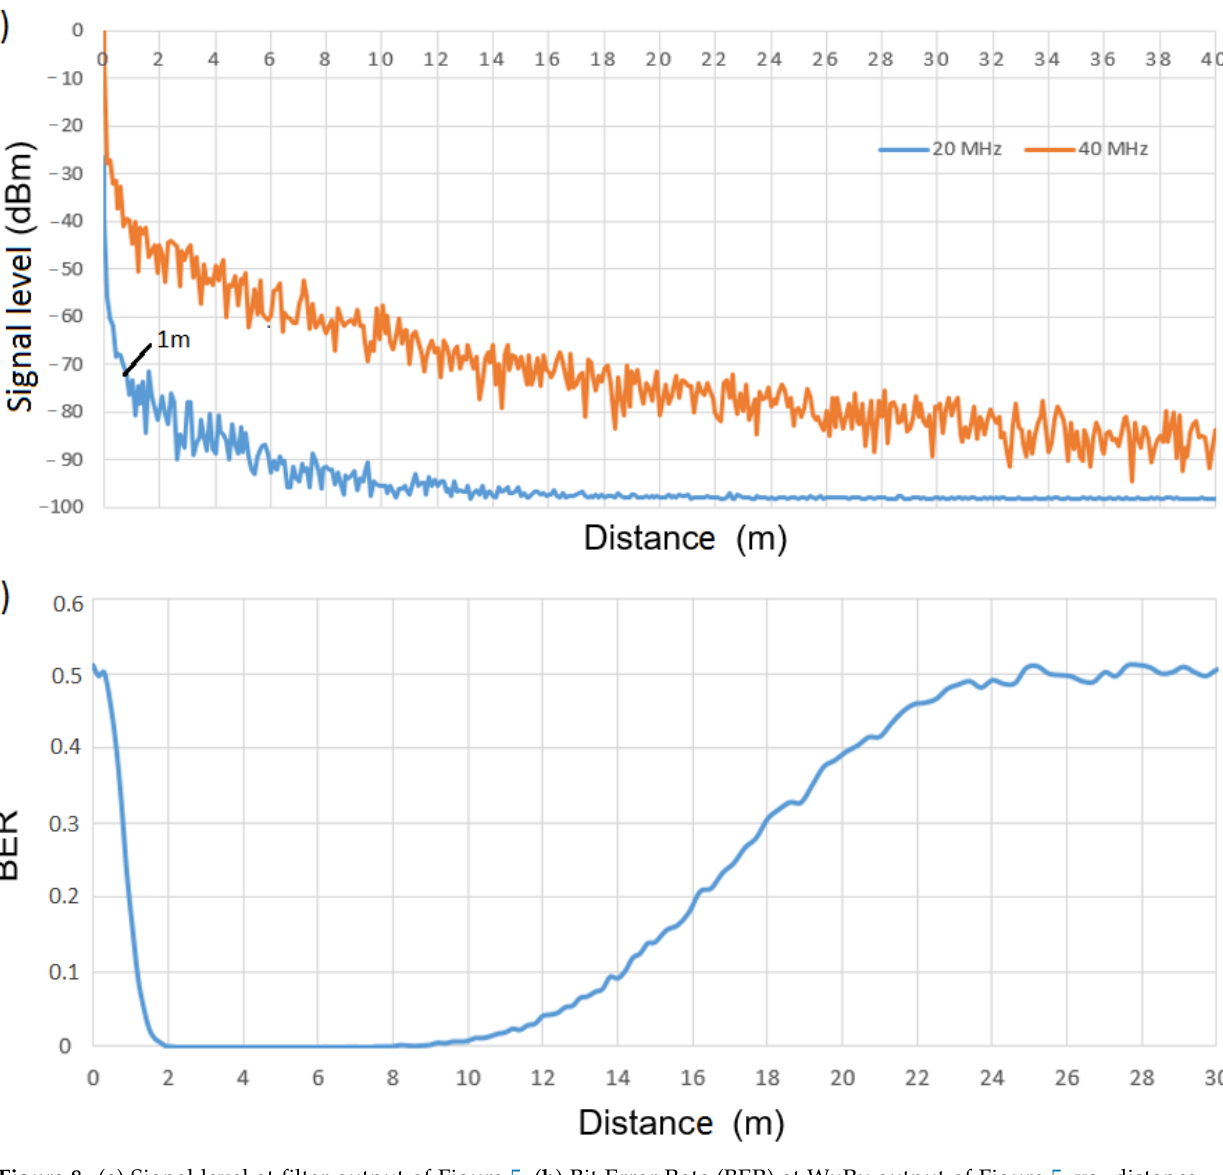
Figure 8. ( a ) Signal level at filter output of Figure 5, ( b ) Bit Error Rate (BER) at WuRx output of Figure 5, vs. distance, employing 20 MHz and 40 MHz signals.